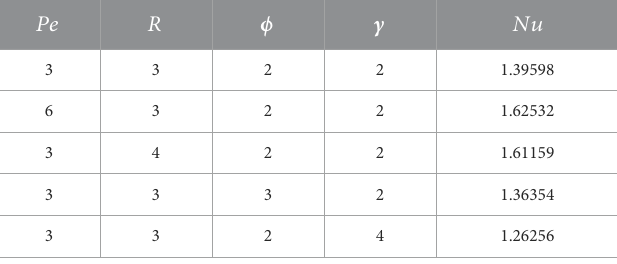
TABLE 1 In fl uence of different parameters on Nu .